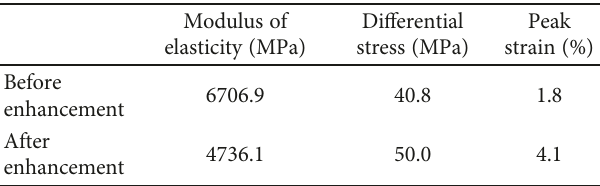
Table 5: Triaxial test